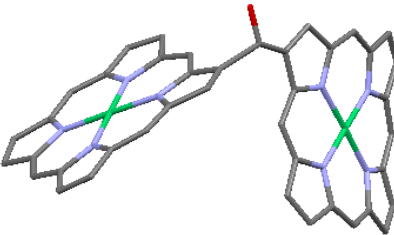
Figure 10. –C(OH)– covalent β - β linkage in OEP-based dimer. From data of [7,22,23]. Peripheral substituents are omitted for clarity. Green = Ni, red = O.